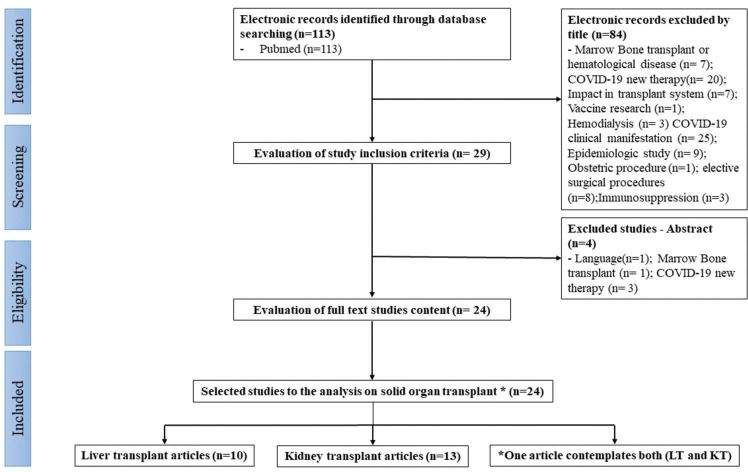
Flow diagram of the systematic literature search according to the PRISMA statement. *Kidney transplant (KT) and liver transplant (LT).